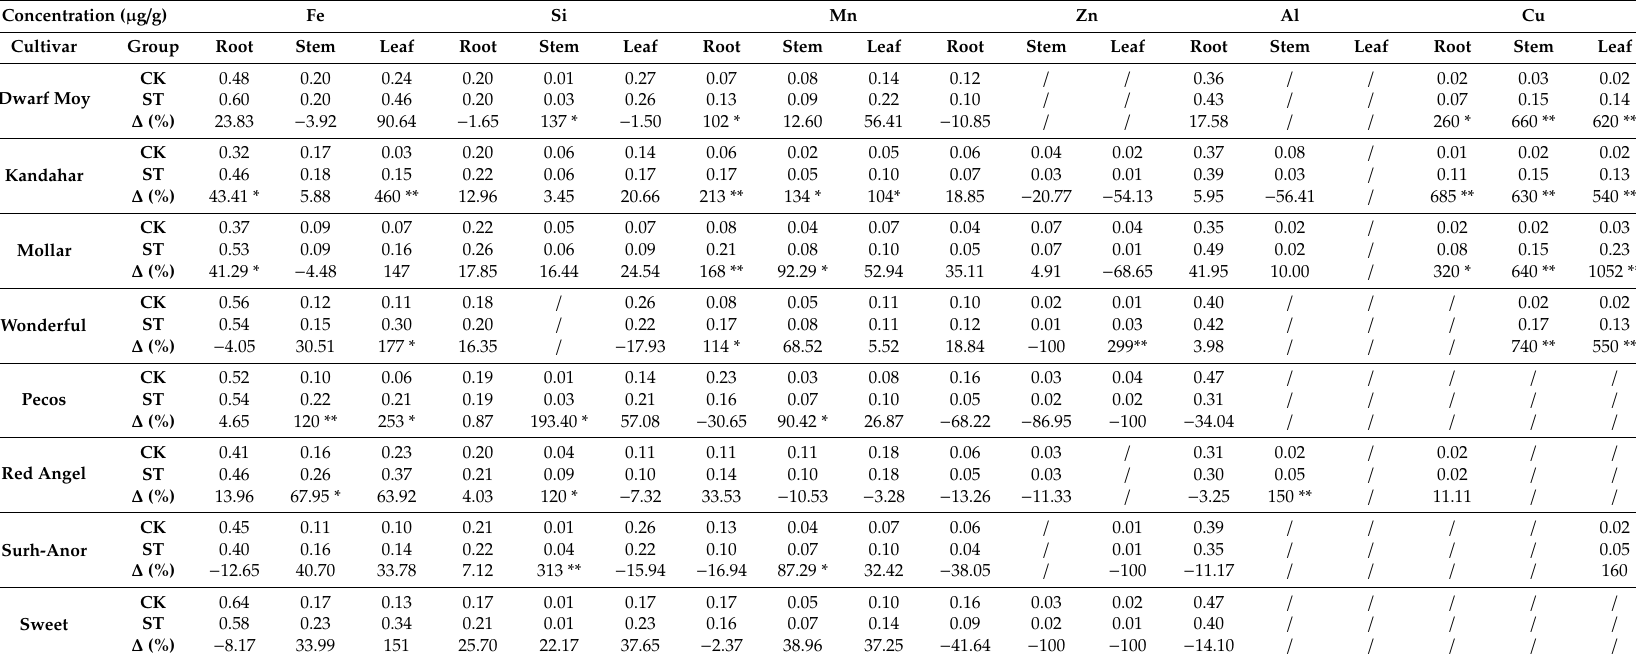
Table 6. The accumulation of microelements in pomegranate roots, stems and leaves under salt